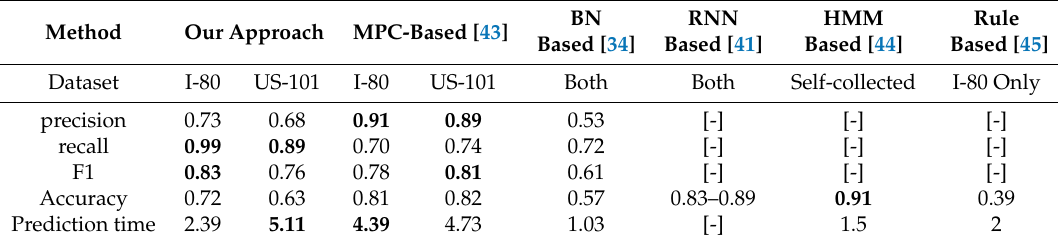
Table 7. Performance comparison of different